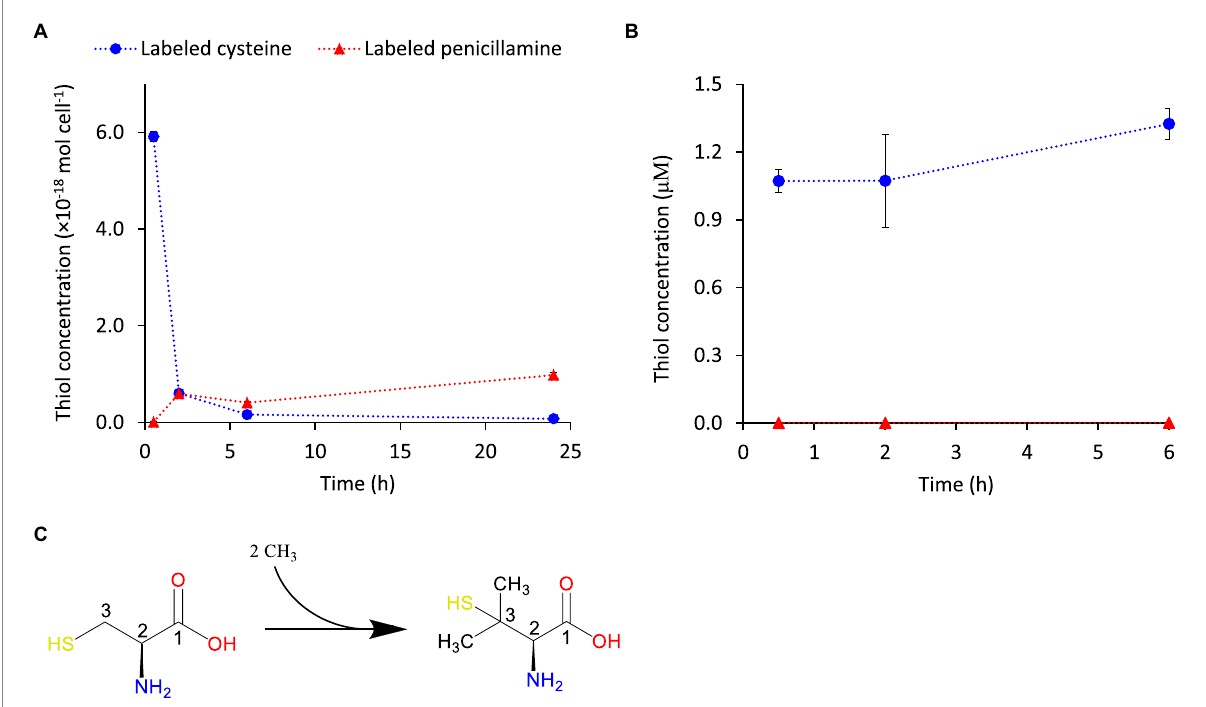
FIGURE 6 Concentrations over time of isotopically labeled cysteine (blue circles) and penicillamine (red triangles) in extracellular assay buffer following the addition of 1.0 μ M of isotopically labeled cysteine (L-Cysteine- 13 C 3 , 15 N) in (A) the presence of G. sulfurreducens cells in “Standard buffer” and in (B) the absence of cells but in the presence of extracellular metabolites isolated from separate cell incubation assays. Error bars represent standard error, n = 3. (C) Reaction scheme illustrating the dimethylation of the C-3 atom of cysteine leading to the formation of